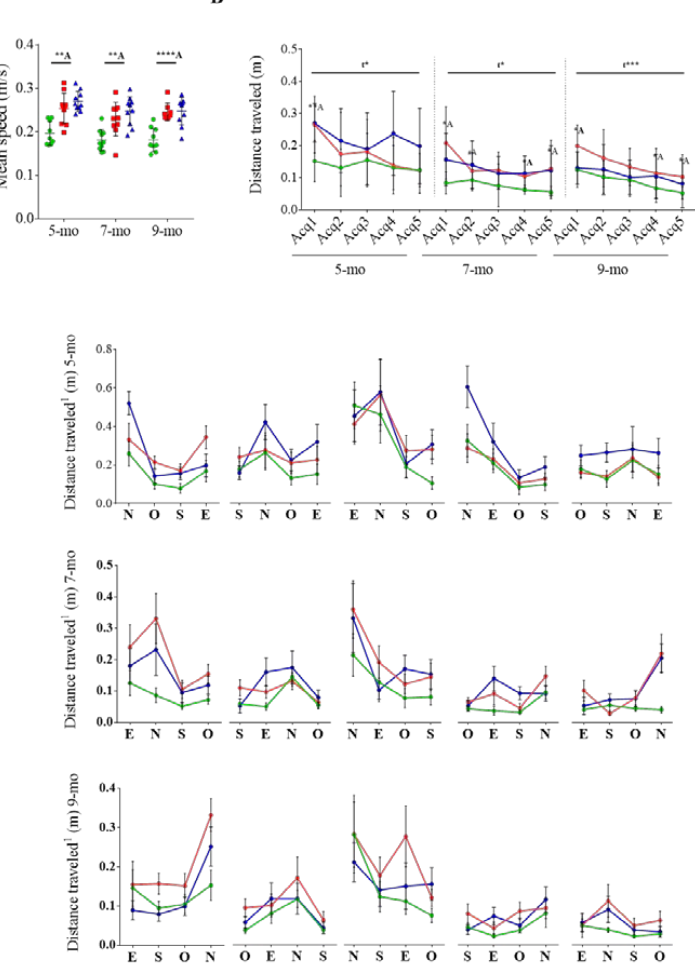
Figure 4. Longitudinally assessed acquisition phase in the MWM paradigm. NTg mice in green, 3xTg-AD mice in red, and scFv-h3D6-treated 3xTg-AD in blue. ( A ) Averaged swimming speed. ( B ) Distance traveled in each acquisition stage. ( C ) Detailed distances traveled in each trial, from the preliminary visible-platform phase to the last acquisition stage. Values are represented by the mean and error bands correspond to SD. # indicates a low, but not significant, p -value 0.05 < p ≤ 0.1 (Distance travelled (m), 9-month, Acq 2, NTg vs. 3xTg-AD-PBS, t = 1.770, p = 0.0957), * significant differences p ≤ 0.05, ** p ≤ 0.01, *** p ≤ 0.001, **** p ≤ 0.0001. A refers to NTg mice.